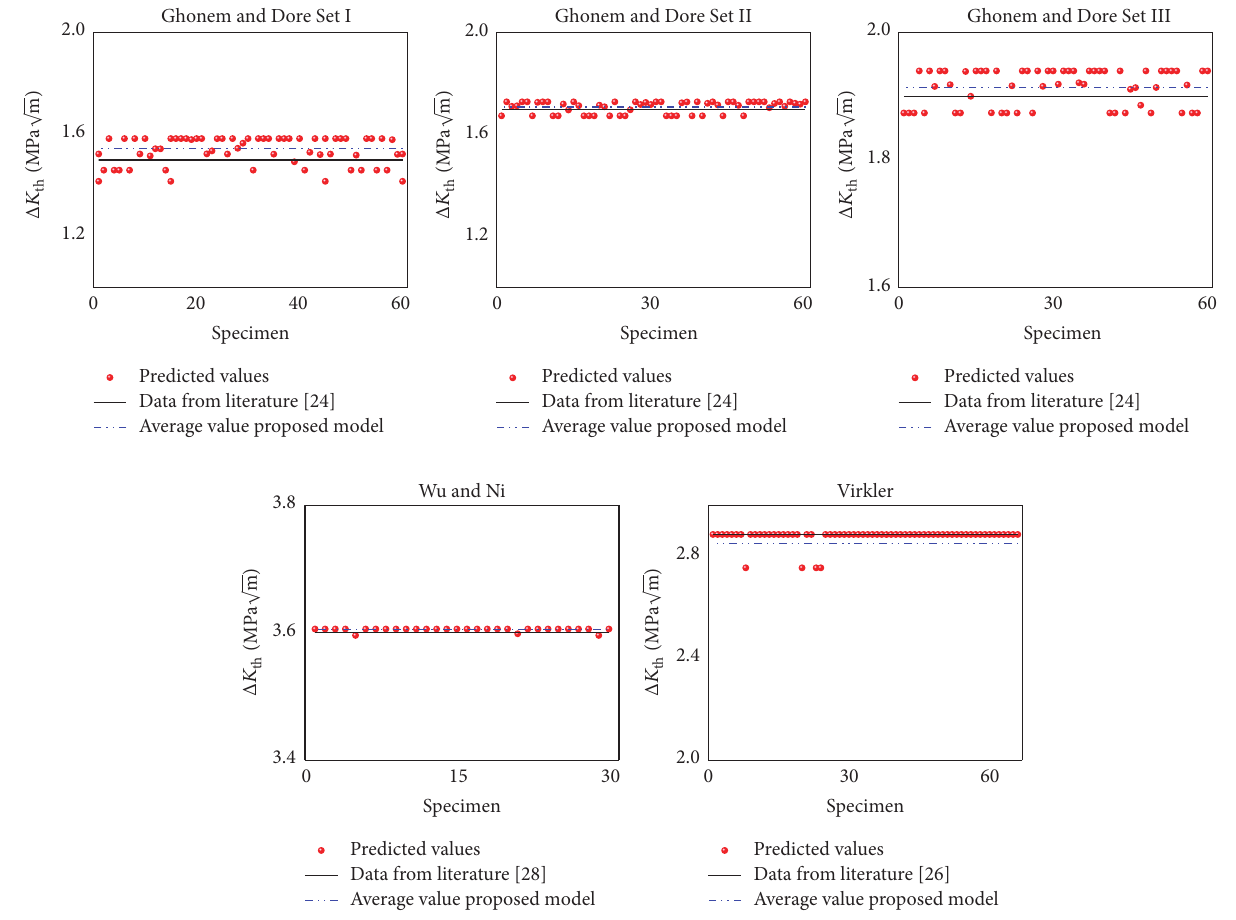
Figure 6: Threshold SIF range for the five